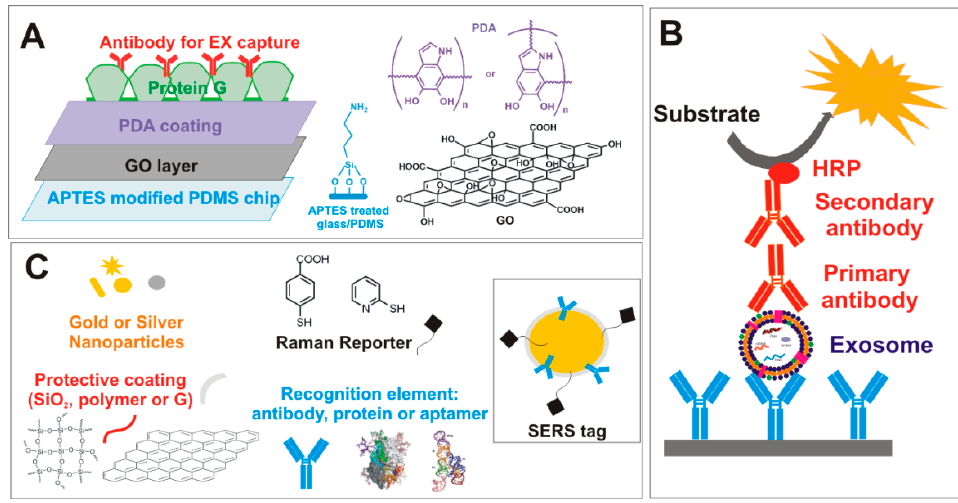
Figure 2. ( A ) Representative structure of the microfluidic platform based on graphene oxide / polydopamine (GO / PDA) for the immunocapture of exosome. ( B ) Representative EXs detection by ELISA colorimetric test using horseradish peroxidase (HRP) as a reporter enzyme in the secondary antibody. ( C ) Surface-enhanced Raman scattering (SERS) tag with related SERS tag toolbox.